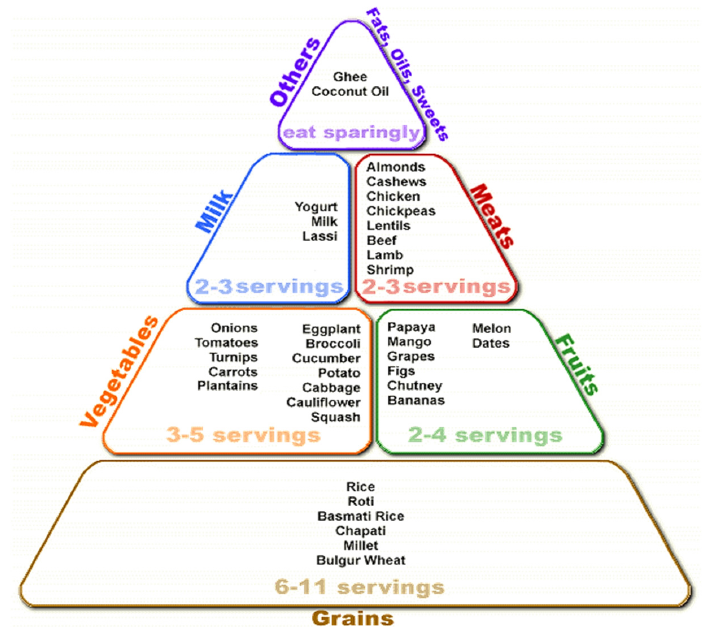
Figure 10. The Indian food guide.